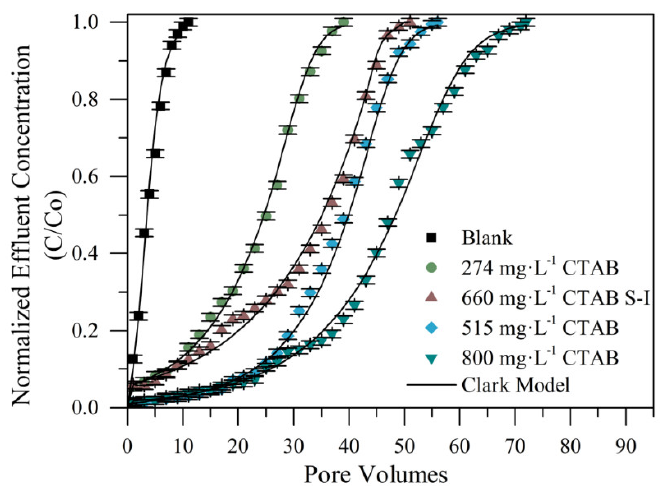
Figure 13. Breakthrough curves comparing results of free CTAB in system I (S-I) at a fixed concentration of nanoparticles (660 mg · L − 1 ) with di ff erent percentages of CTAB adsorbed onto the nanoparticles at a fixed concentration of nanoparticles (660 mg · L − 1 ) in system II, assessed with a kaolinite 0.2% in mass fraction solution at 25 ◦ C.